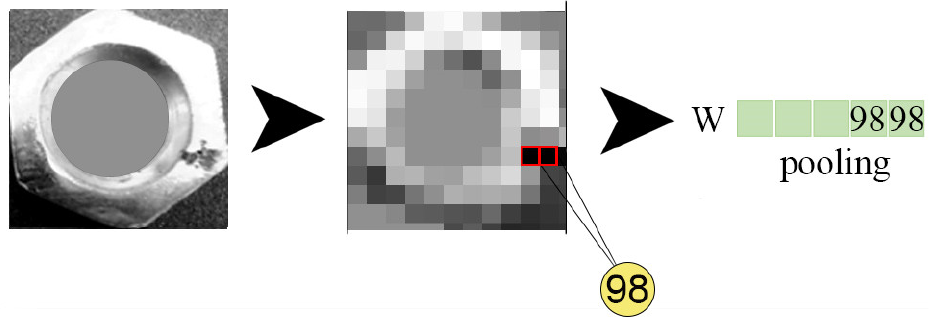
Figure 12. Detected k percentage values of the metal nut piece whose surface image is captured (belongs to the defective product).